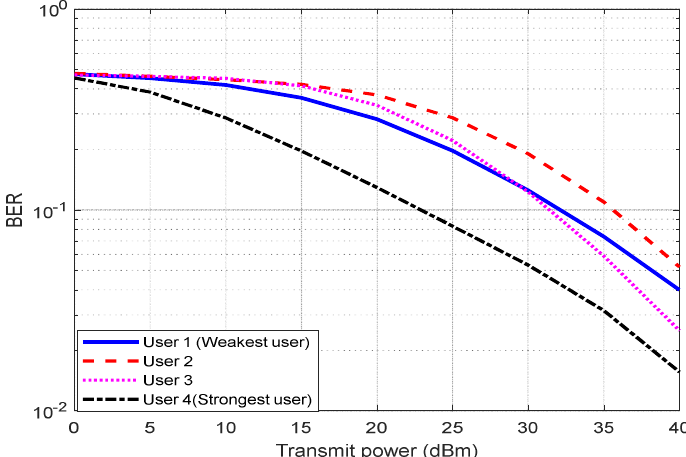
Figure 3. BER vs. transmit power for four users with varying distances and power coefficients, for DL NOMA at BW (80 MHz).